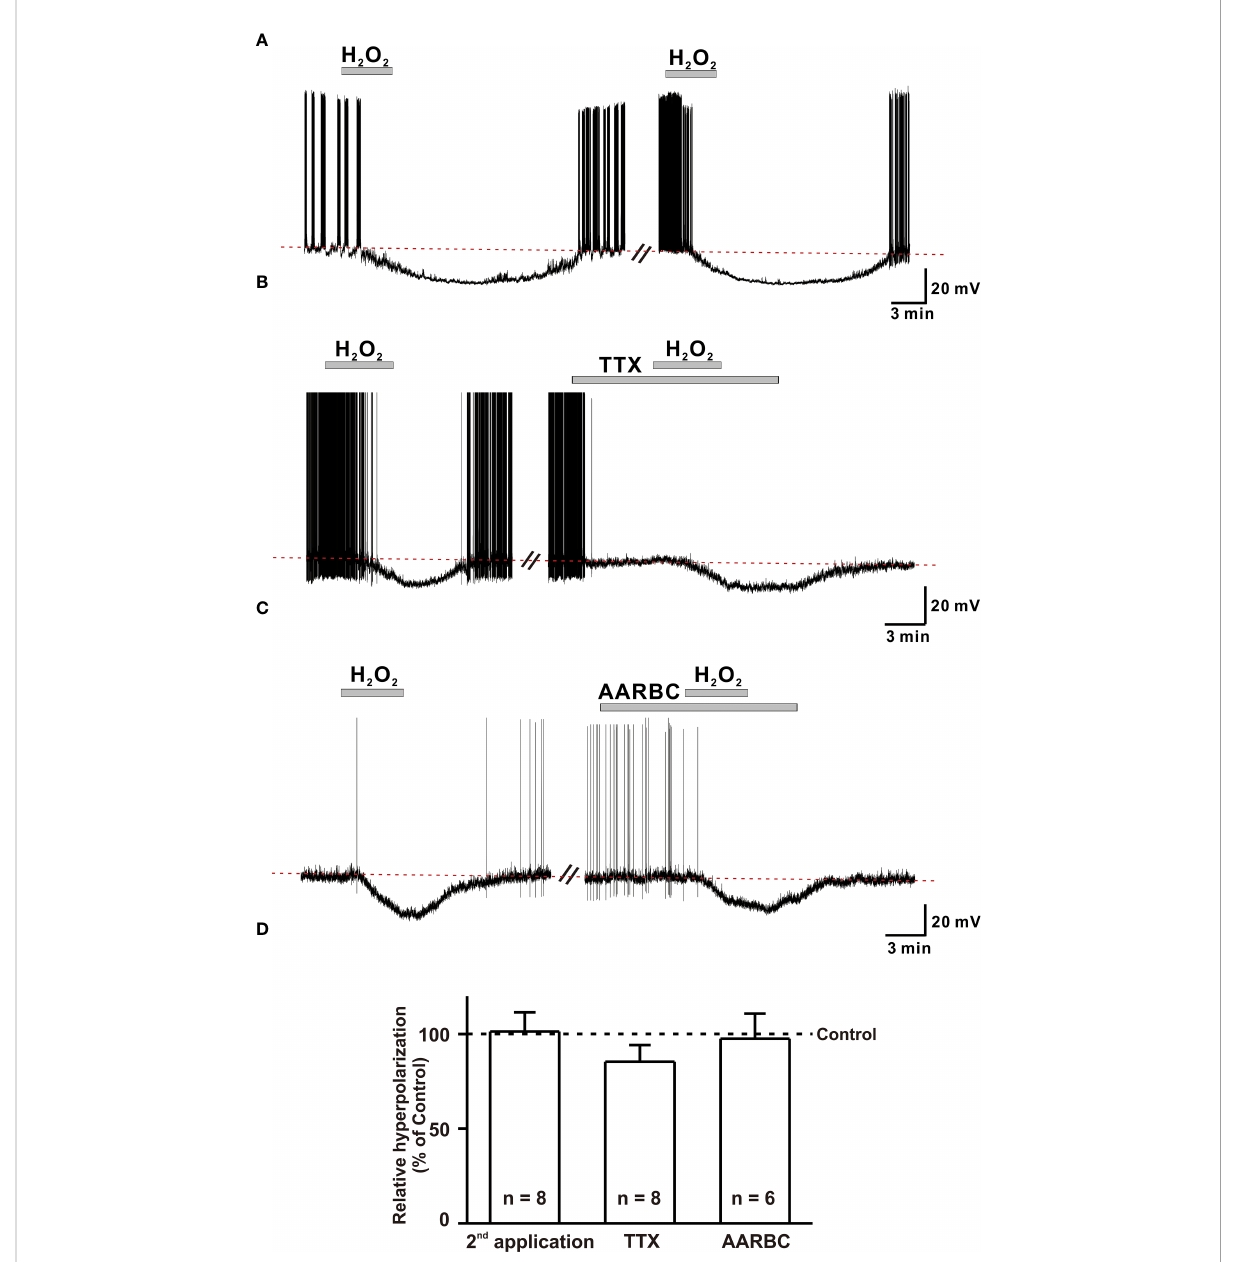
FIGURE 4 H 2 O 2 acts on GnRH neurons post-synaptically. (A) A representative trace showing repeatable hyperpolarization induced by 1 mM H 2 O 2 under a whole-cell current clamp. (B, C) Representative traces showing persistence of H 2 O 2 induced hyperpolarization response in the presence of (TTX, 0.5 m M), the voltage-sensitive Na+ channel blocker and amino-acid receptor blocking cock-tail (AARBC), respectively. (D) A bar diagram showing mean relative values of hyperpolarization induced by 1 mM H 2 O 2 on 2 nd application, in the presence of TTX, and in the presence of AARBC ( p > 0.05; paired t